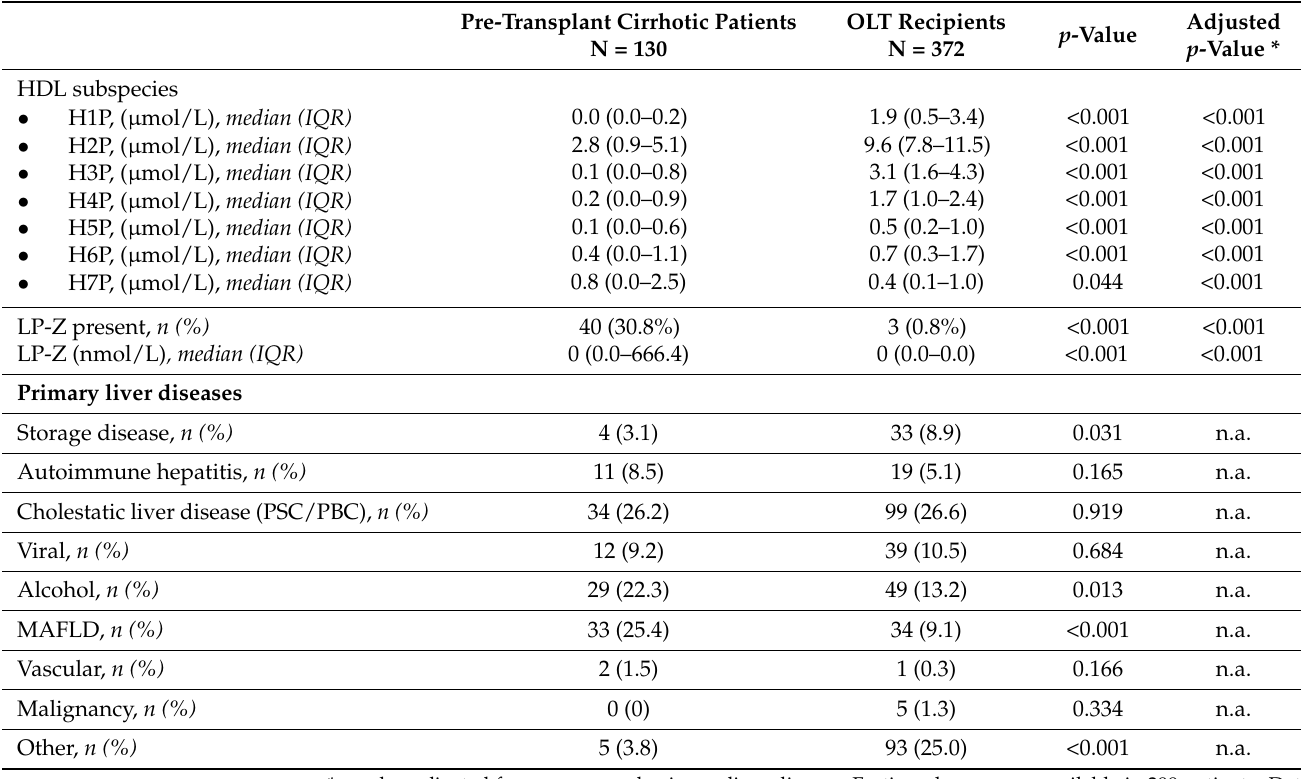
Table 1. Cont. Pre-Transplant Cirrhotic